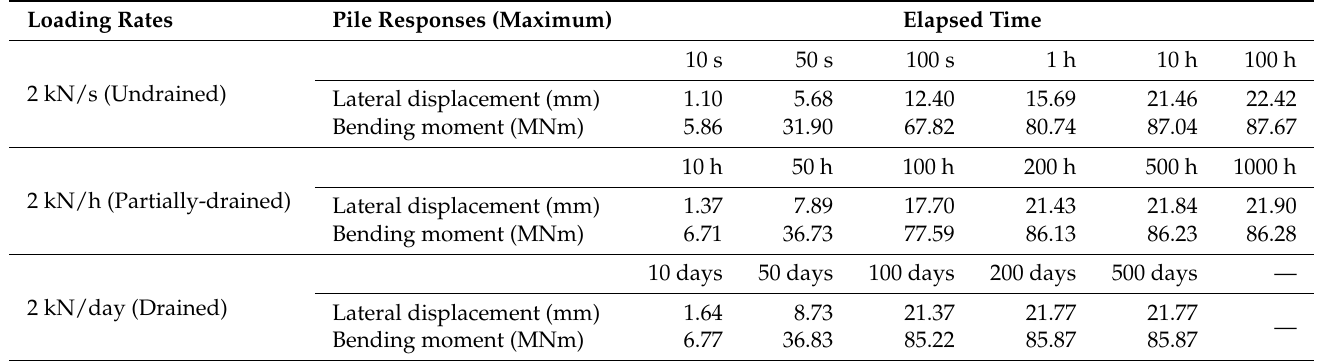
Figure 3. Responses of pile under various loading rates: lateral displacement under the rate of ( a ) 2 kN/s (undrained); ( b ) 2 kN/h (partially drained); ( c ) 2 kN/day (drained); bending moment under the rate of ( d ) 2 kN/s (undrained); ( e ) 2 kN/h (partially drained); and ( f ) 2 kN/day (drained). Table 2. Maximum pile responses under various loading rates and different elapsed